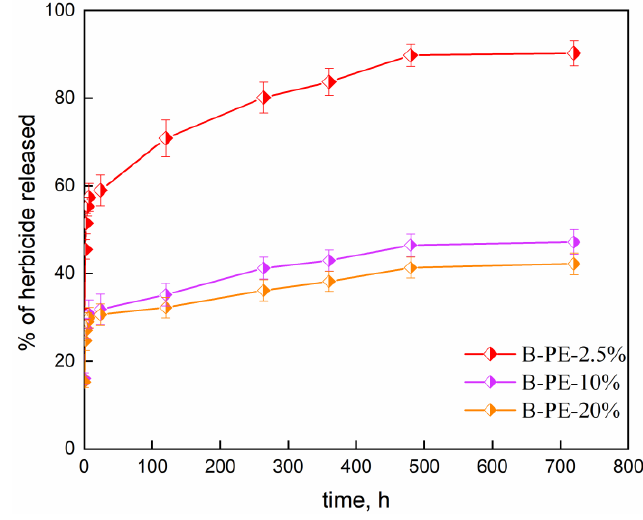
Figure 9. Release kinetics of Capsaicin.